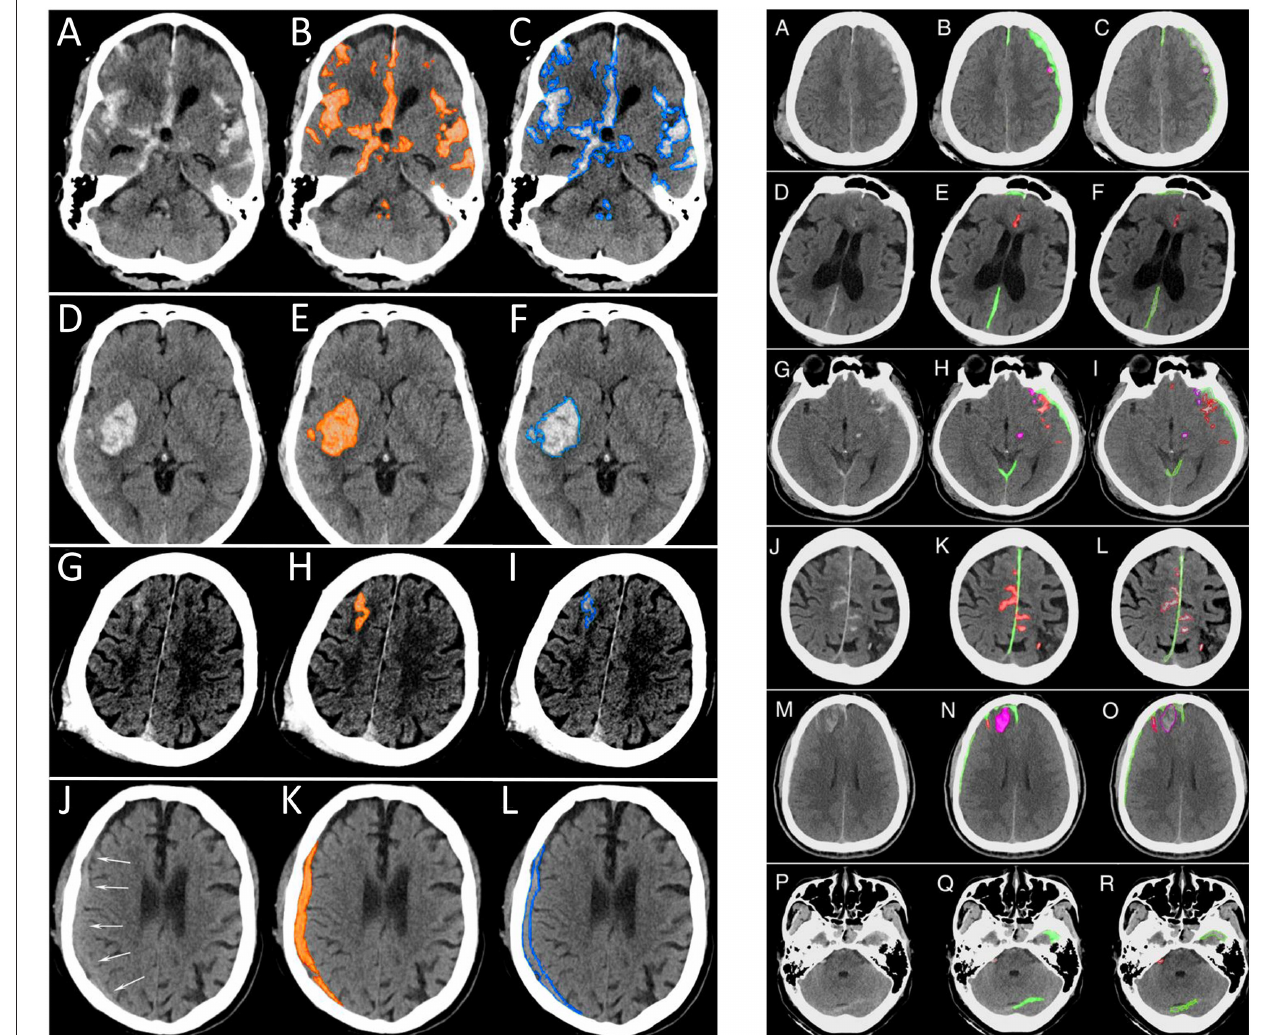
FIGURE 10 | Examples of intracranial hemorrhage detection, classification, and segmentation by a convolutional neural network (CNN) (29). (Left) Binary segmentations, in which the model indicates the presence or absence of intracranial hemorrhage only. (A,D,G,J) . The first column shows the original head CT images. (B,E,H,K) The middle column shows the same images with orange shading of pixel-level probabilities > 0.5 for intracranial hemorrhage as determined by the CNN. (C,F,I,L) The third column shows the original images with a blue outline drawn by an expert neuroradiologist around all areas of intracranial hemorrhage. (Right) Multiclass segmentations, in which the model not only detects intracranial hemorrhage but additionally indicates the hemorrhage subtype. (A,D,G,J,M,P) The first column shows original head CT images. (B,E,H,K,N,Q) The second column shows the algorithm’s predictions. Each subtype is indicated by a different color, where subdural hematoma is green, brain contusion is purple, and subarachnoid hemorrhage is red. (C,F,I,L,O,R) The third column shows the “ground truth” labels drawn by expert